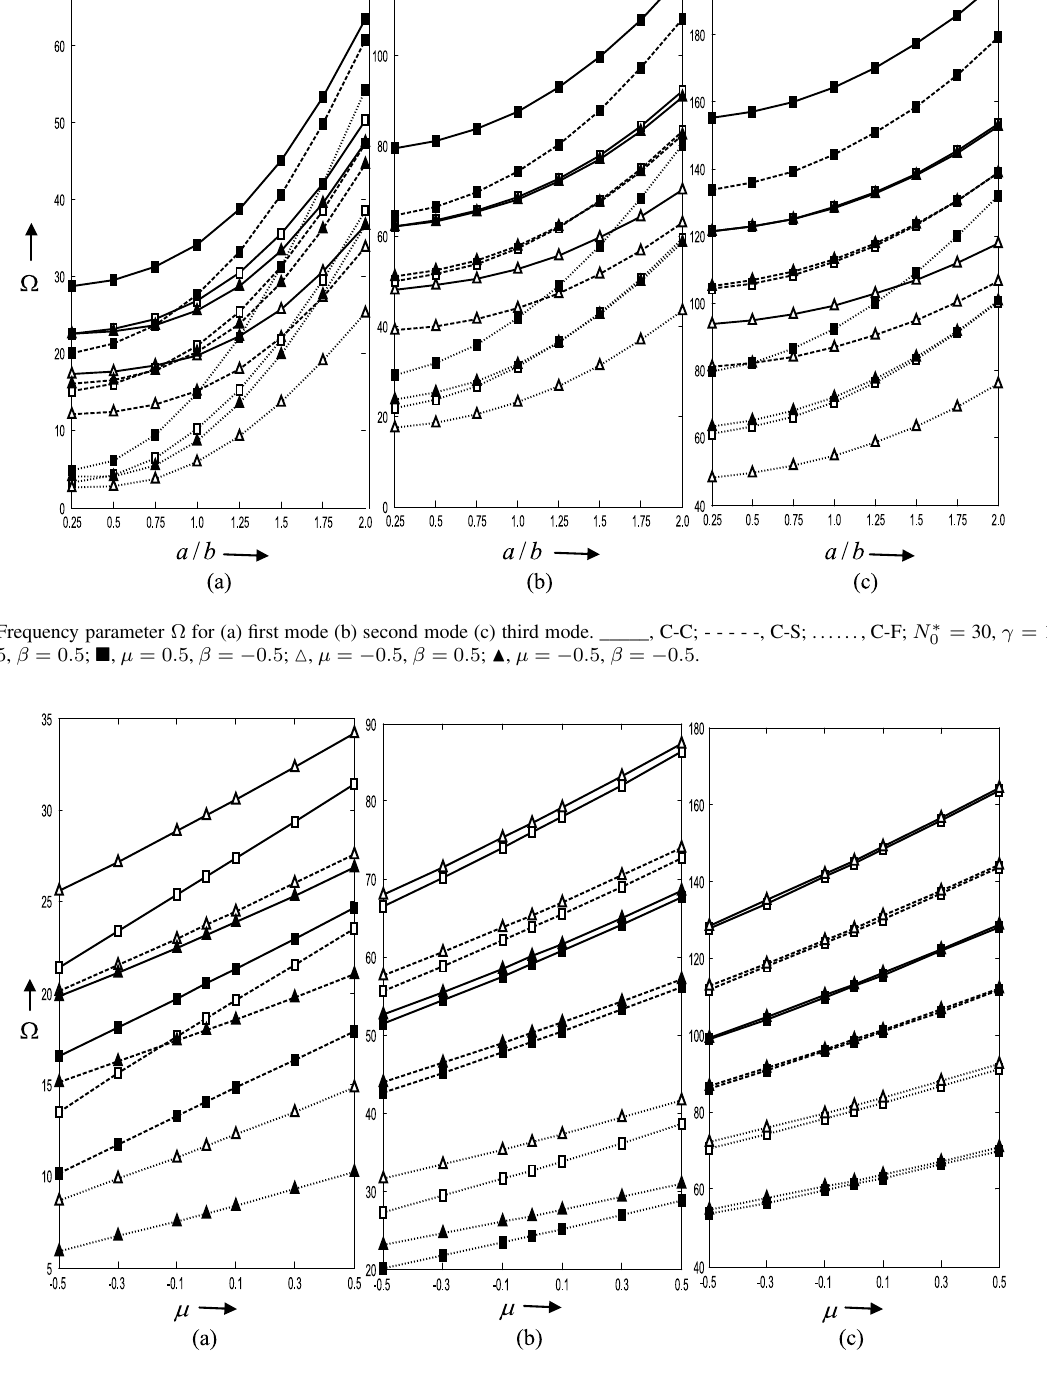
Fig. 7. Frequency parameter Ω for (a) first mode (b) second mode (c) third mode. _____, C-C; - - - - -, C-S; ......, C-F; N ∗ 0 = 30, a/b = 1 ; (cid:3) , β = − 0 . 5 , γ = 0 ; (cid:5) , β = 0 . 5 , γ = 0; (cid:4) , β = − 0 . 5 , γ = 1 ; (cid:6) , β = 0 . 5 , γ = 1